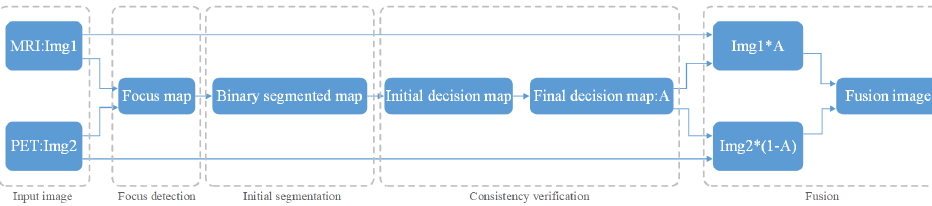
Figure 5. Process of image